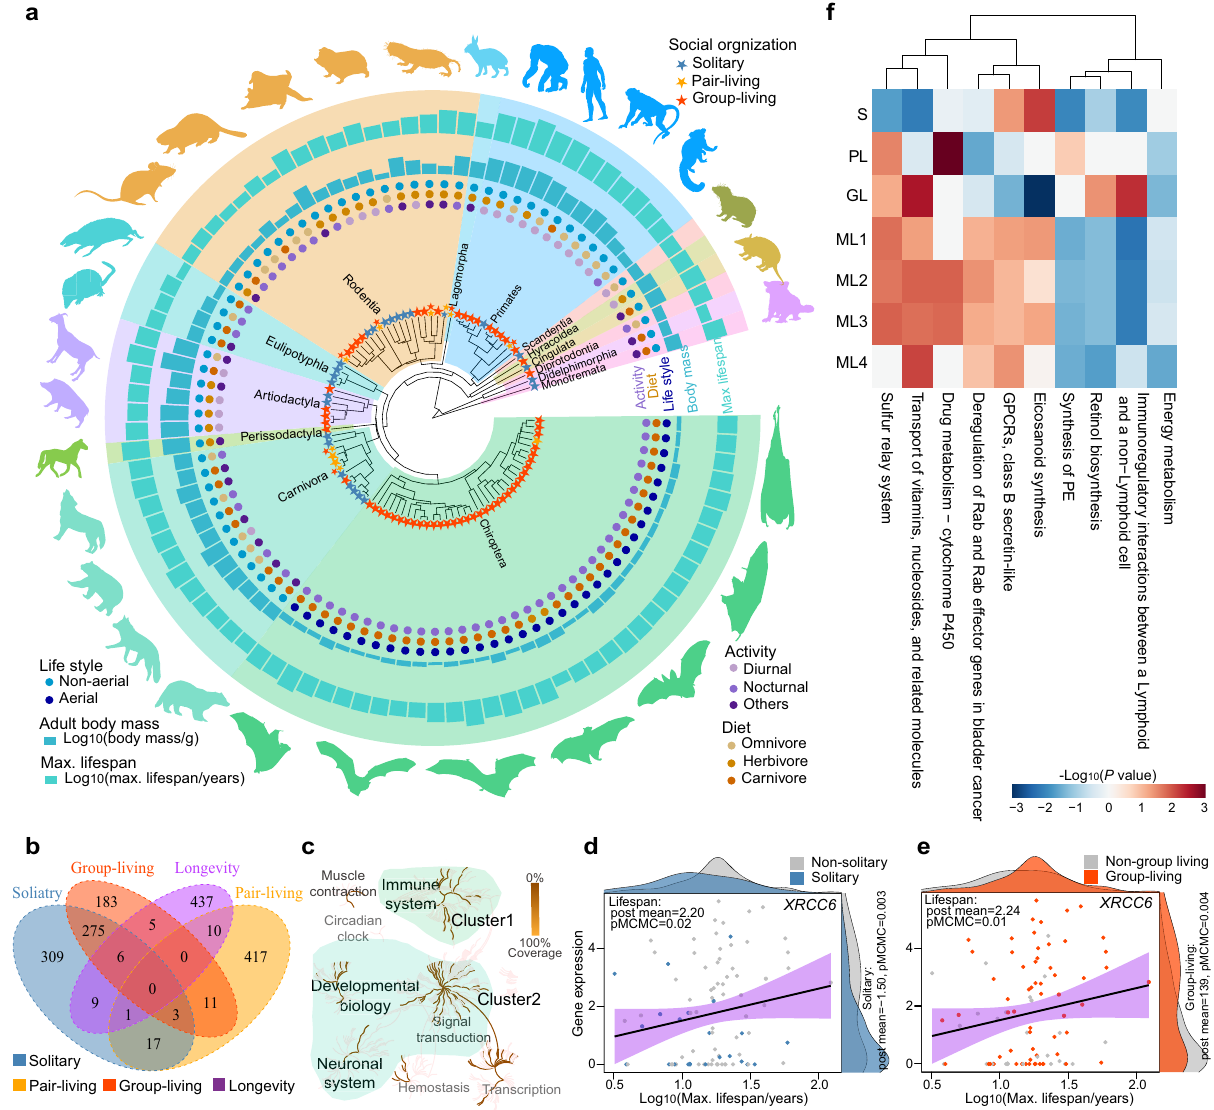
signi fi cantgene( XRCC6 )thatwasdownregulatedinsolitaryspecies,upregulatedin group-living species and also positively correlated with lifespan; the regression lines were generated from the linear regression model. Purple range display 95% con fi dence interval around the smooth line. Coef fi cients (post mean) and P -values (pMCMC) from the MCMCglmm analyses are also shown. The number of species used in the MCMCglmm was n =94. f A heat map showing pathways that were signi fi cantly associated with social organization and longevity. S: solitary; PL: pair- living;GL:group-living;ML1 – ML4:longevityinmodel1tomodel4(see “ Methods ” ). Color code for social organization and longevity: blue = solitary; orange = pair- living; red = group-living; purple = lifespan. Source data are provided as a Source data fi